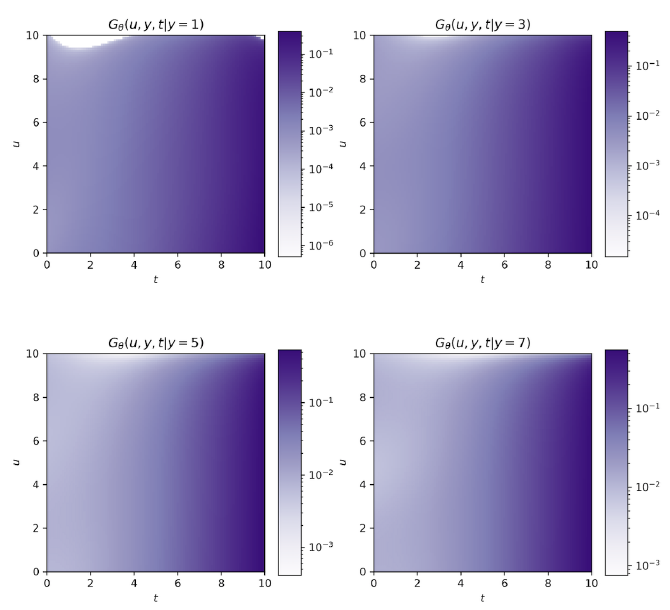
Figure 12. The values of G θ ( u , y , t ) for a given y (Pareto